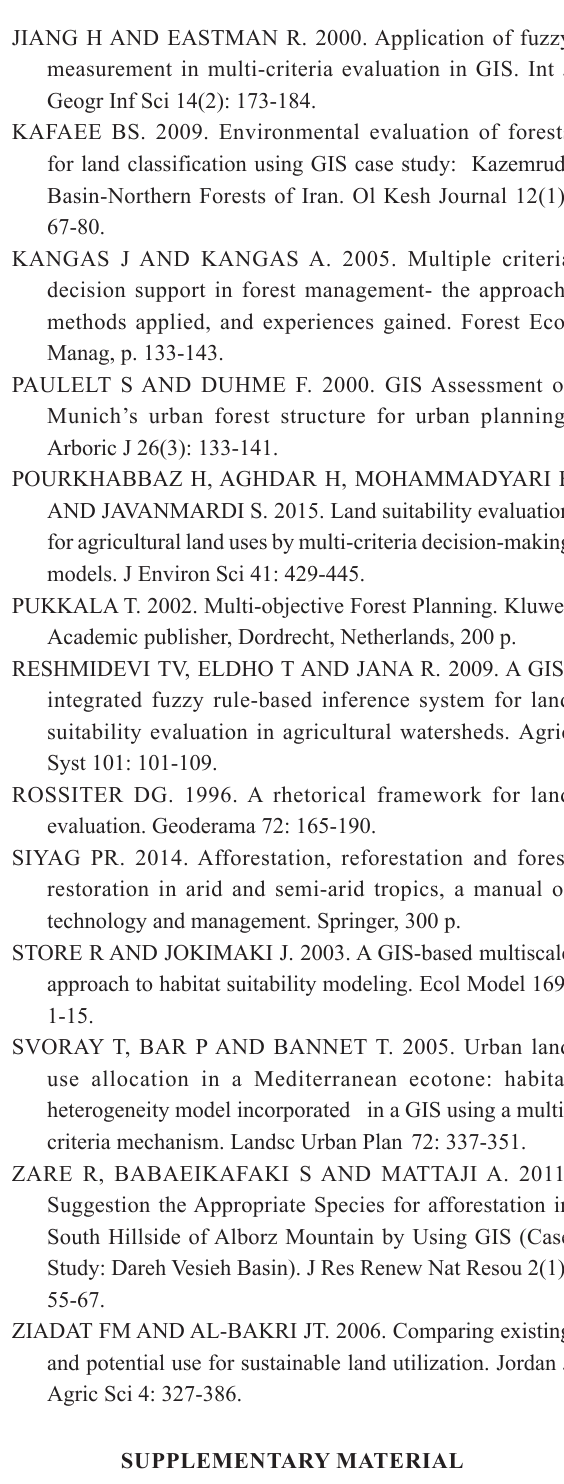
Figure S1 - Pairwise comparison matrix. Figure S2 - Pairwise comparison matrix. Figure S3 - The resulting weights of the